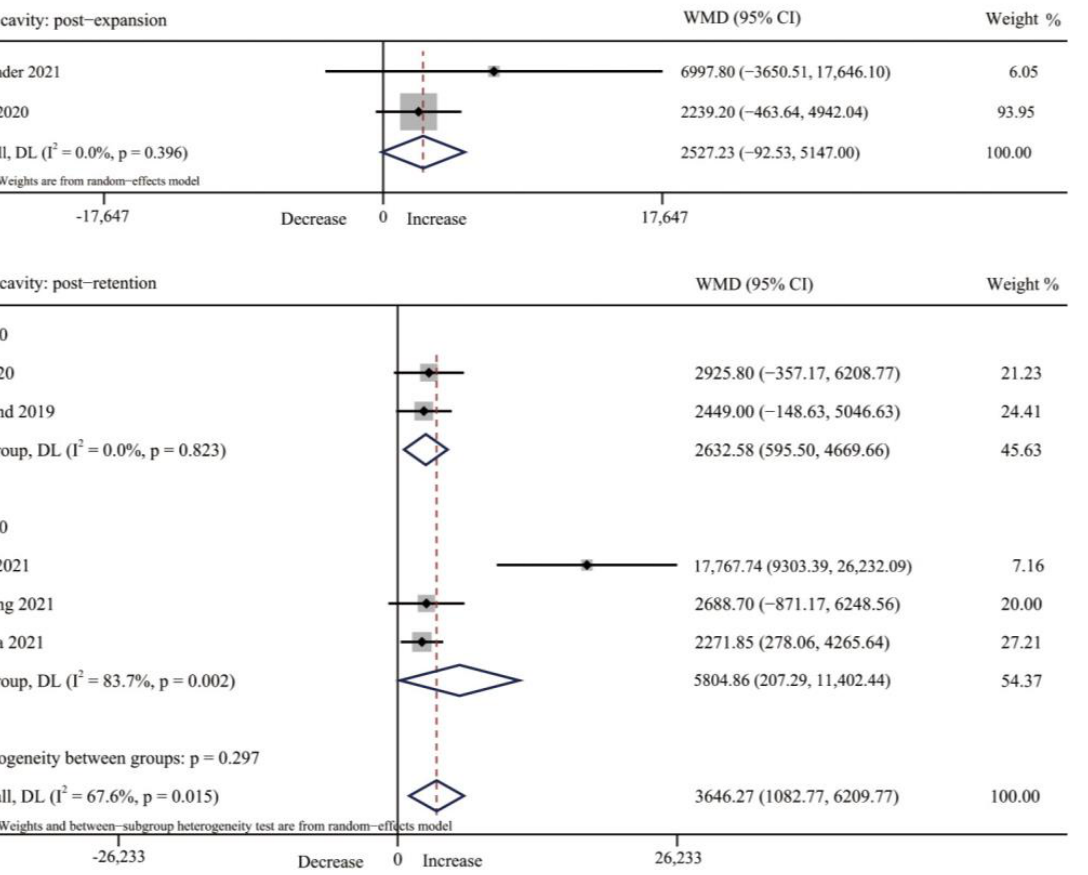
Figure 4. Forest plot for the changes of nasal cavity volume immediately after expansion (T1) and retention (T2–T3). T0, before expansion; T1, immediately after expansion; T2, three months after expansion; T3, six months after expansion; WMD, weighted mean difference; CI, confidence interval [32,35,37 – 39,41,42].